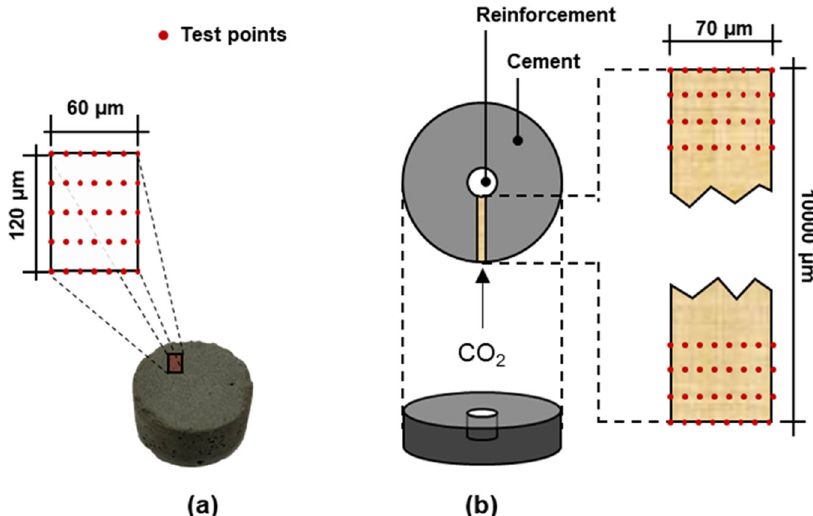
Fig. 9 Diagrams showing the test points for data collection. a Test points for type 1 specimens. b Test points for type 2